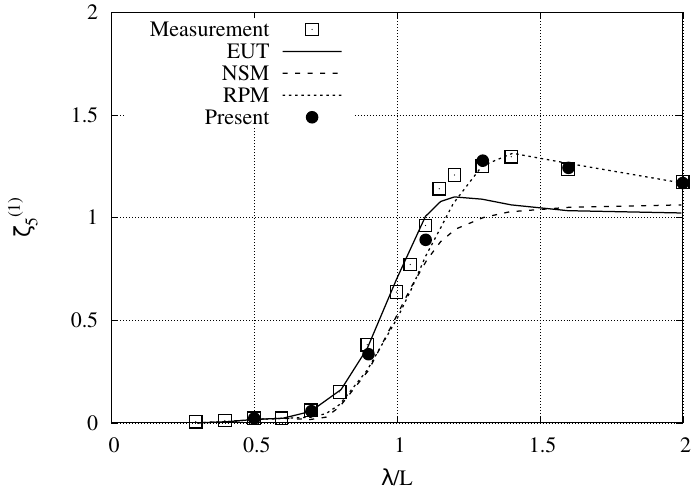
Figure 6. The first harmonic amplitude of the pitch against the wave